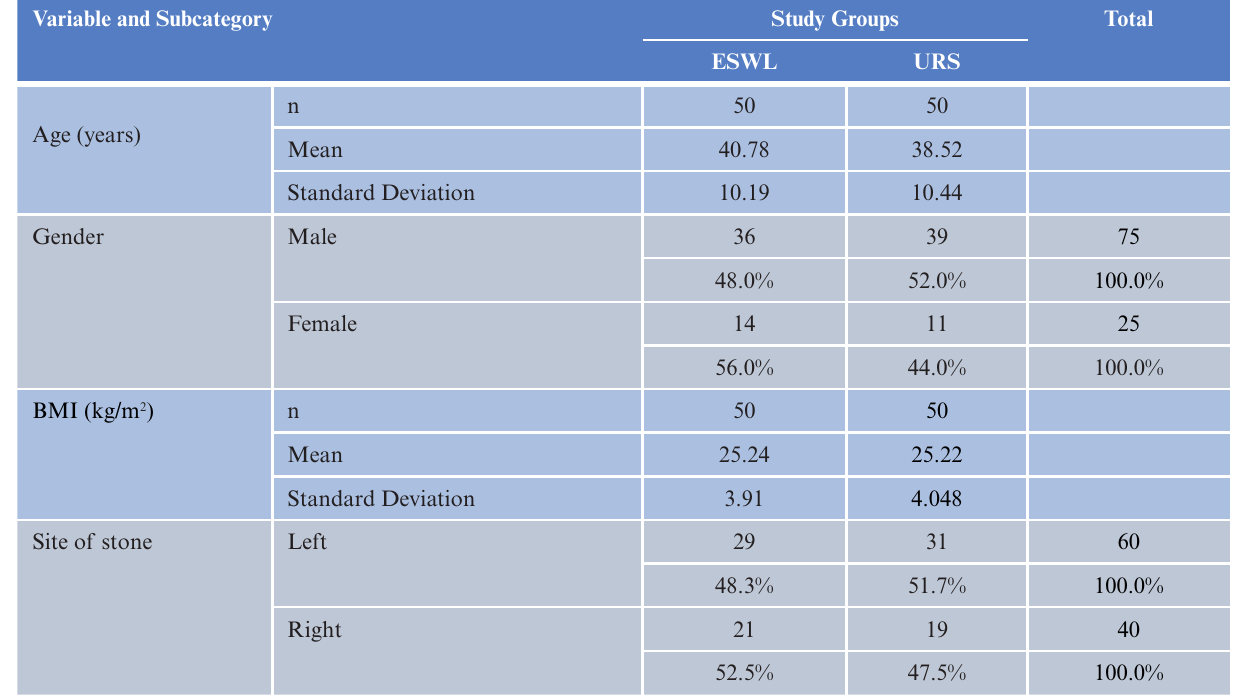
Table 1: Summary statistics of age (years), gender, BMI (kg/m 2 ) and frequency distribution of side of stone between study